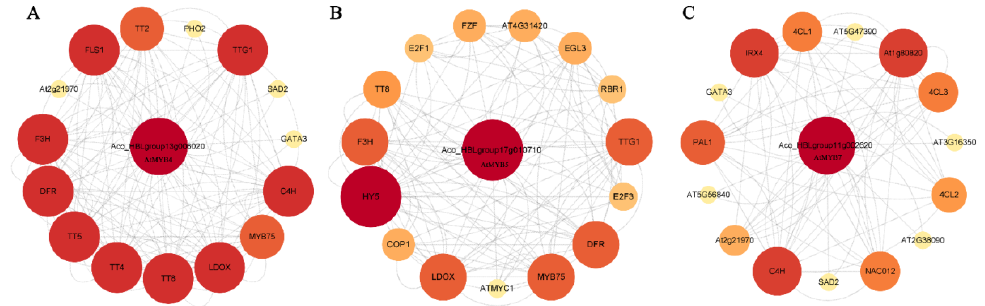
Figure 5. Protein interaction network of Aco_HBLgroup13g006020 ( A ), Aco_HBLgroup17g010710 ( B ), Aco_HBLgroup11g002620 ( C ) according to AbR2R3-MYB orthologs in Arabidopsis .